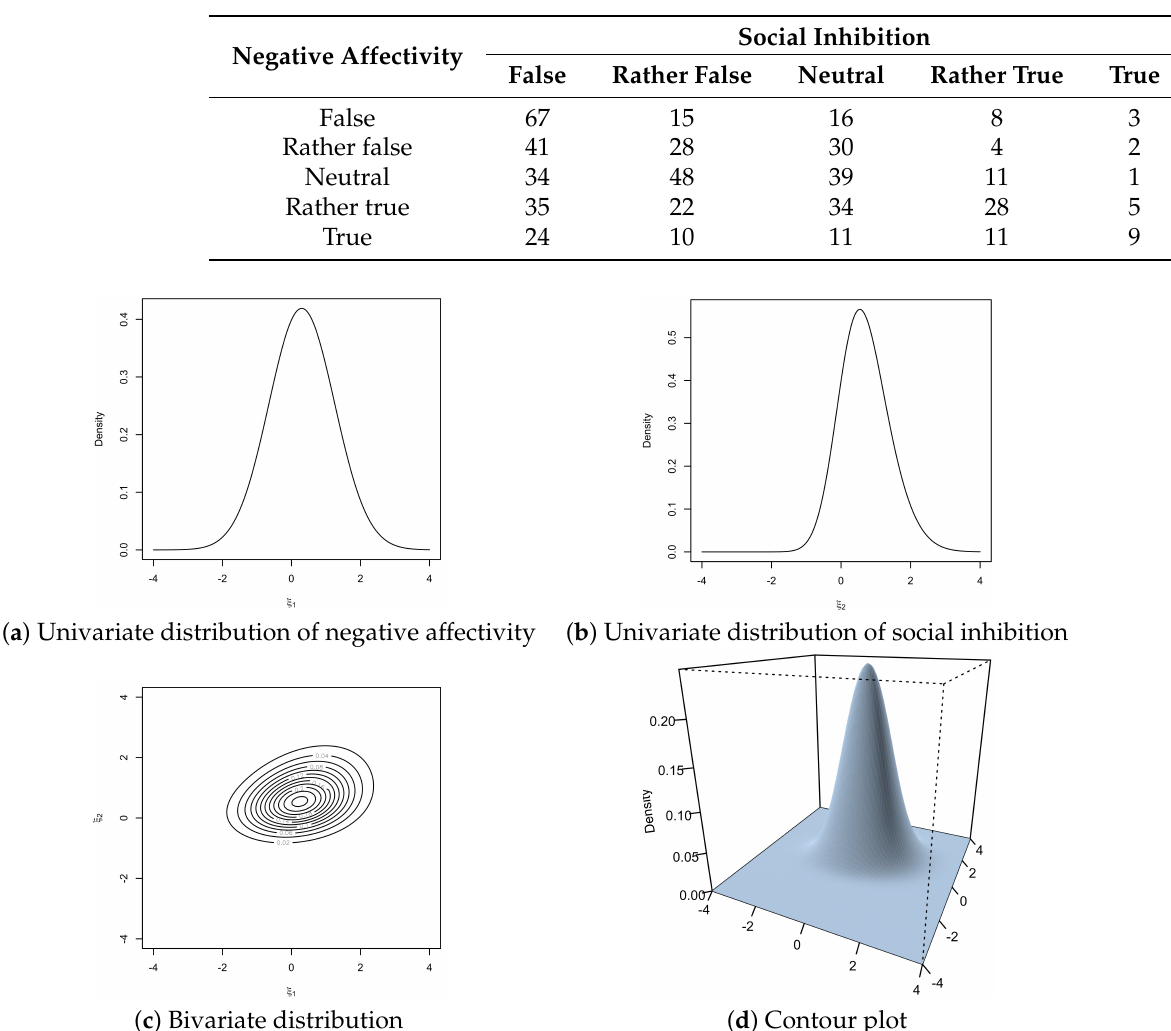
Figure 1. The univariate distributions ( a , b ), bivariate ( c ) and contour plot ( d ) of the estimated mixture of bivariate normal distributions for the Type D personality